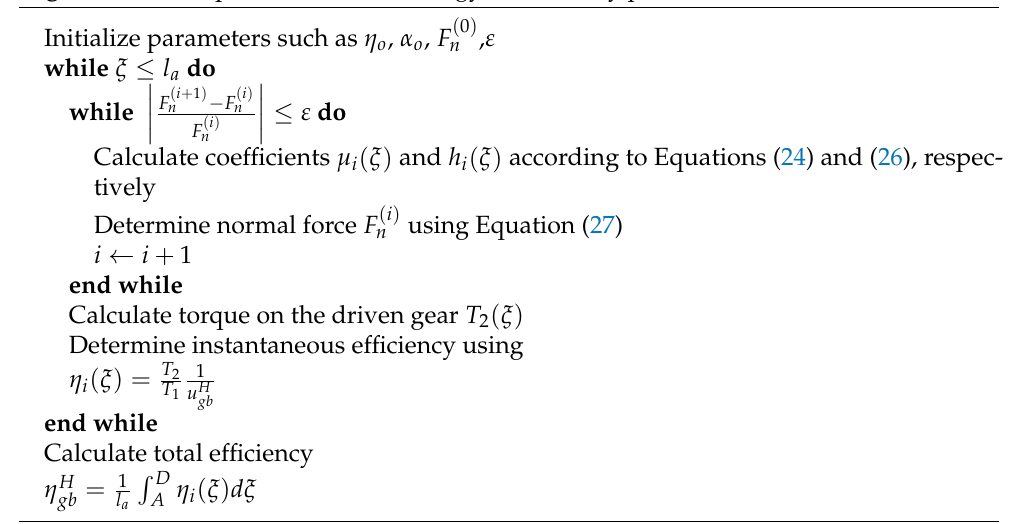
Algorithm 1 Computational methodology of efficiency prediction